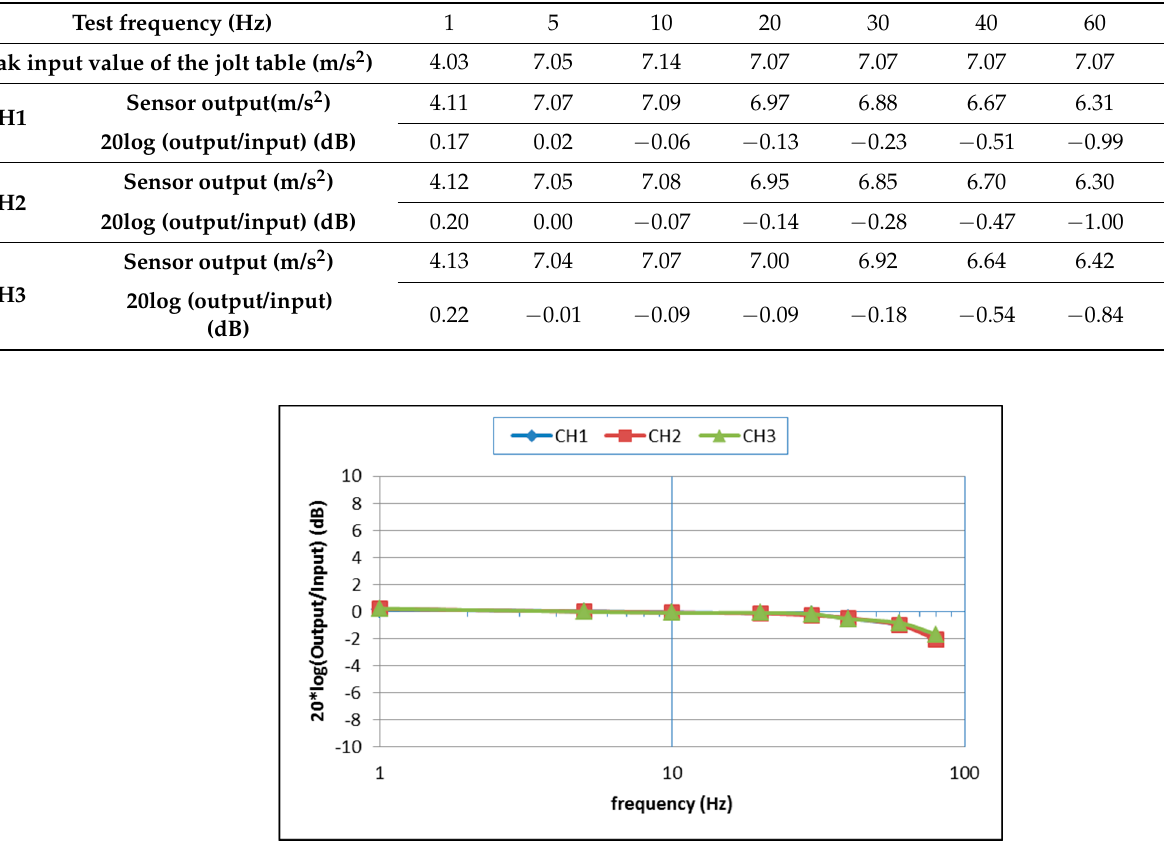
Figure 10. Amplitude–frequency plot of our instrument’s performance on a jolt table.